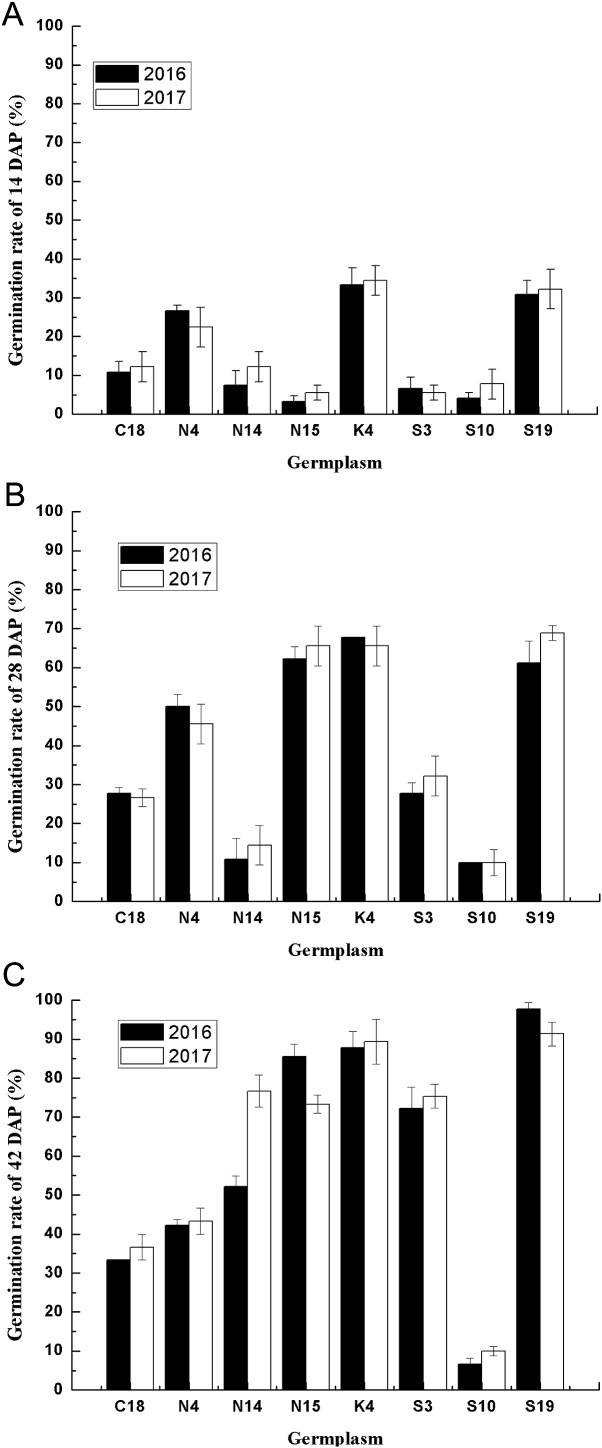
The seed germination patterns of eight germplasm at different developmental stages during two consecutive years.(A) Seed germination at 14 DAP. (B) Seed germination at 28 DAP. (C) Seed germination at 42 DAP. Different letters indicate significant differences between the 2 years. Bars represent the mean ± S.E. (n = 4).